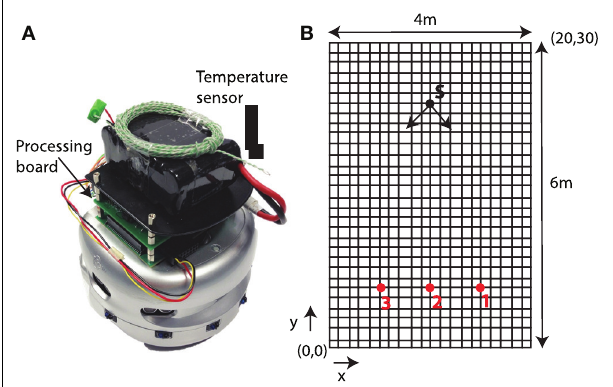
FIGURE 5 | Robotic experiments (proof of concept for fire searching) . (A) Temperature sensor (Thermocouple probe TKA01-5 type K, T.M.Electronics) mounted on a Khepera robot. Preprocessing (amplification × 5000, sampling frequency 1KHz) is performed via a custom-made board. (B) The search space is 6m long by 4m large, resulting in a grid-based model of the environment of 30 × 20 steps. In order to obtain statistically comparable results, all trials reported hereafter are done with the three robots initially located at (x, y) = (5, 6), (10, 6), and (15, 6) and the heat source (S) at (10,24). The heat source had an internal fan with 90° oscillation producing a wind oriented downward with fluctuations around the y axis, as indicated by the